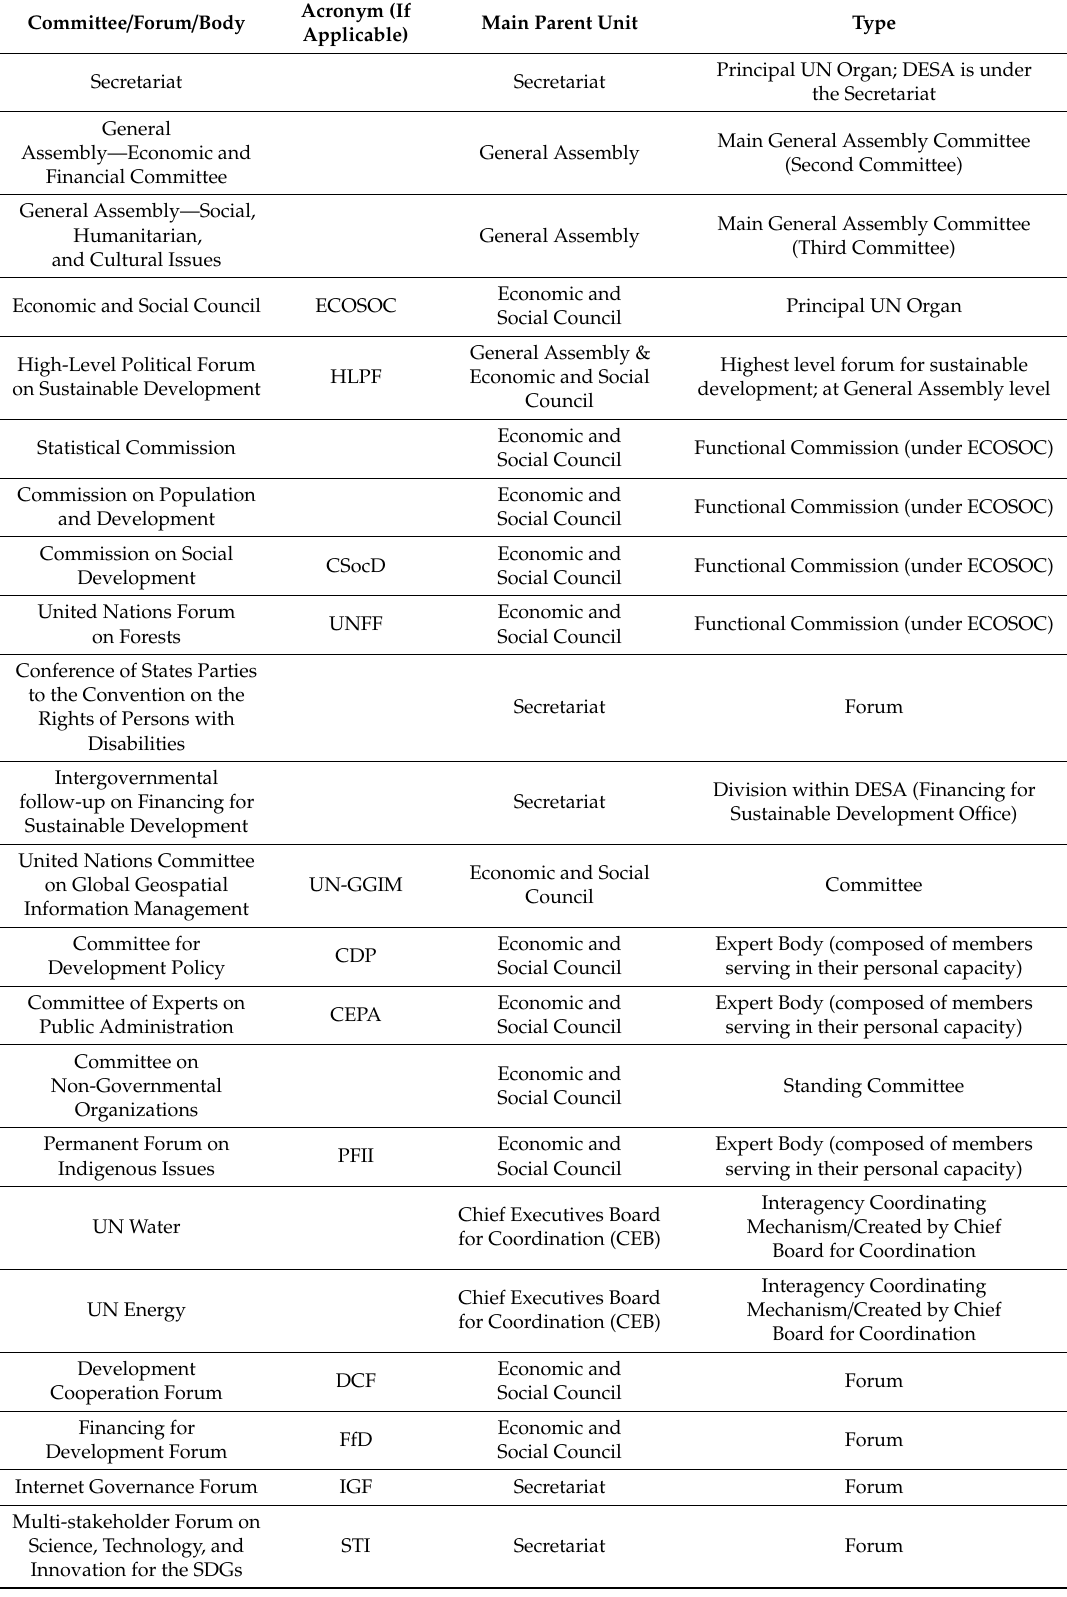
Table 2. Department of Economic and Social A ff airs (DESA) committees, forums, or bodies, their main parent